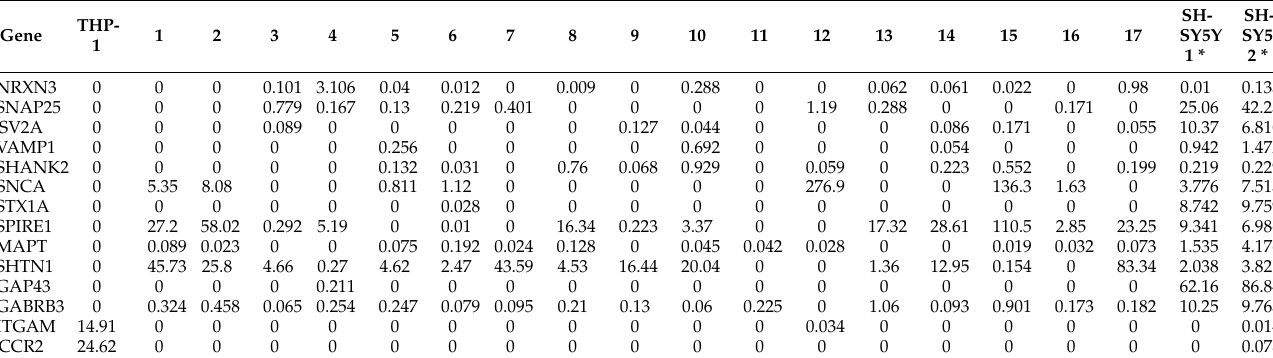
Table 2. Expression of 12 neuronal markers and 2 markers for monocytes in THP-1 monocytic cells, SH-SY5Y neuroblastoma cells and 17